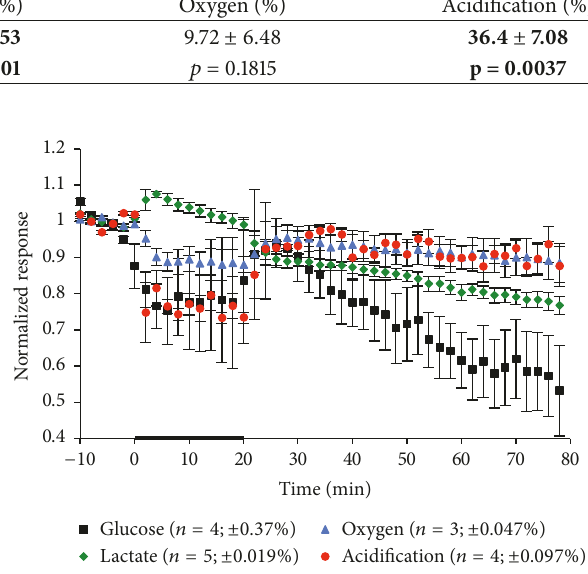
Figure 6: Average metabolic response of RAW 264.7 cells to a 20 min exposure of 25 𝜇 g/mL mouse LOX-1/OLR1 antibody. The black bar indicates the exposure time. The number of experiments and standard error of the mean for the basal metabolic rate 10min before exposure to the antibody are given in